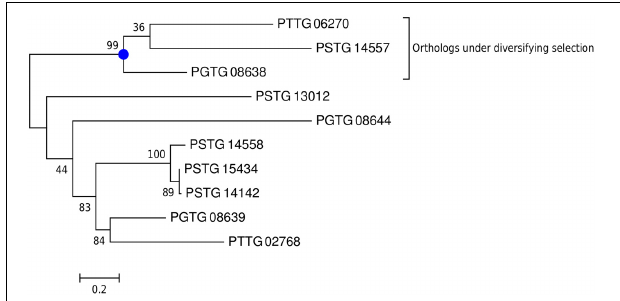
FIGURE 5 | For the gene family of protein PGTG_08638, diversifying selection is only detected for the orthologs. A phylogenetic tree for the gene family of PGTG_08638 was predicted using PhyML and branch support values are shown. PAML detects site-specific diversifying selection only for the branch with the three orthologs (stem rust PGTG 08638, stripe rust PSTG_14557, leaf rust PTTG 06270), but not for the other variants PGTG_08639 and PGTG_08644 and their